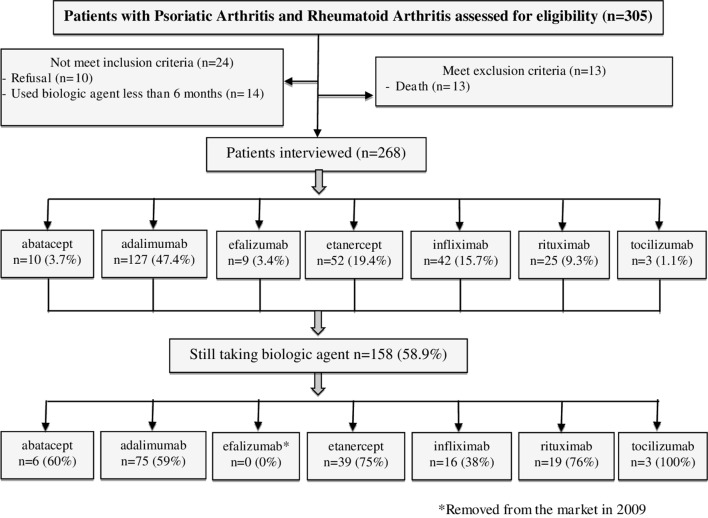
Flow diagram of the steps of the sample composition.